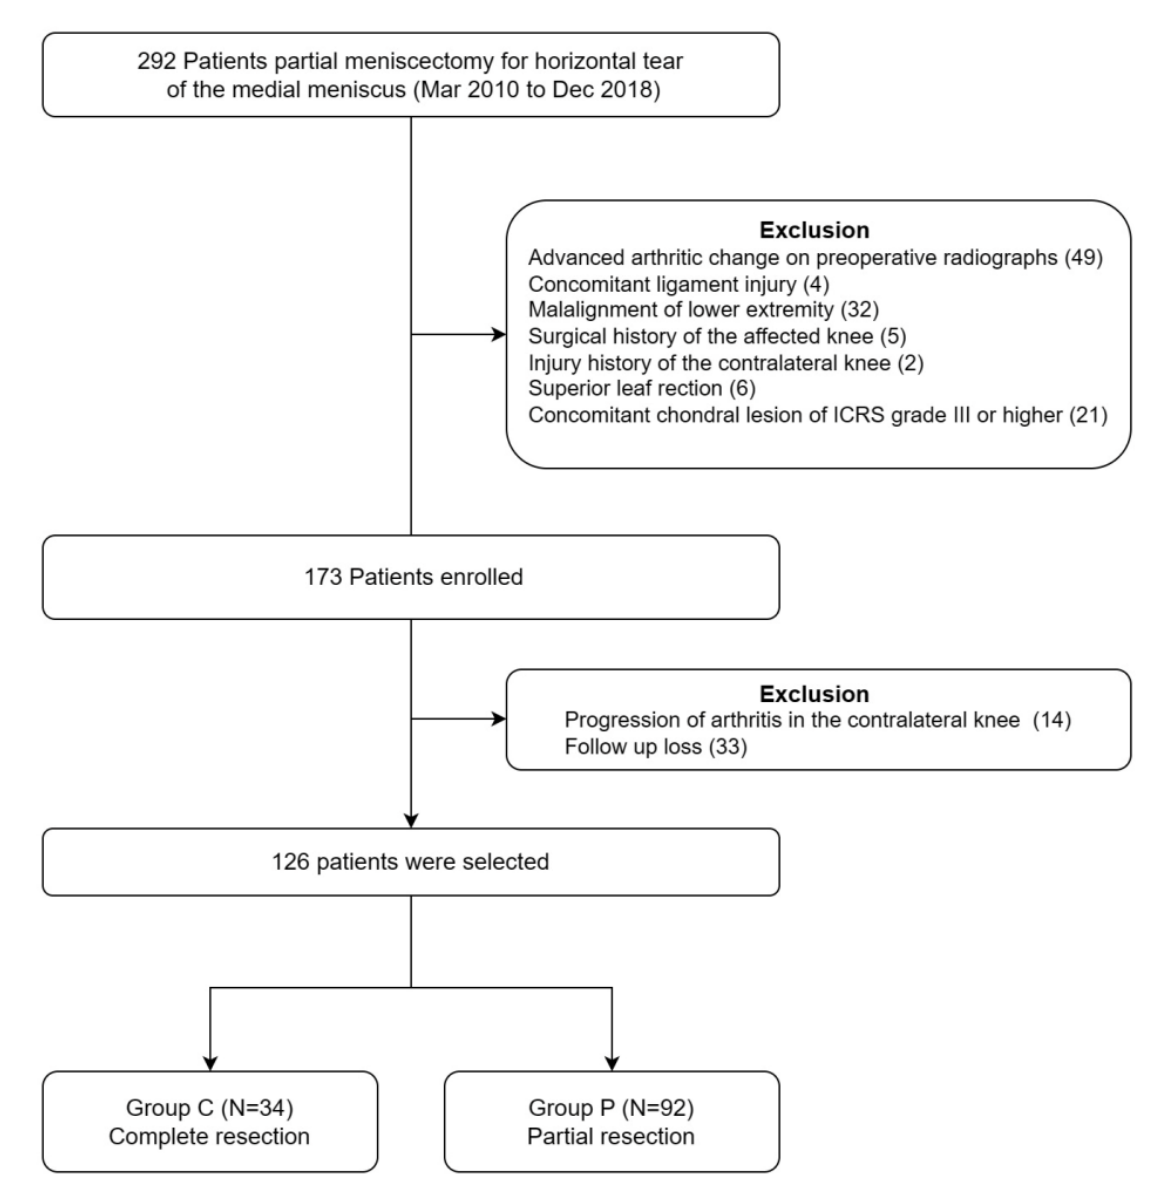
Figure 1. Flowchart of patient inclusion.